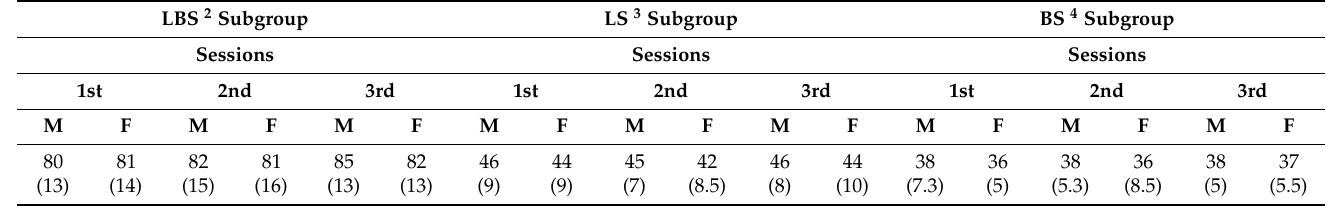
Table 6. Scores 1 of the TGMD-3 divided by sex (males M, females F).